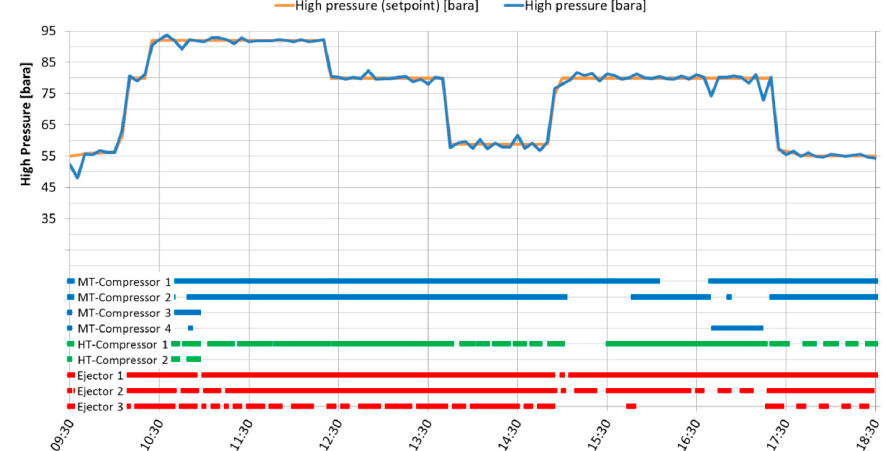
Figure 11. Operating conditions aimed at demonstrating the successful switching from floating condensing to heat recovery mode and vice versa via multi-ejector concept [42].